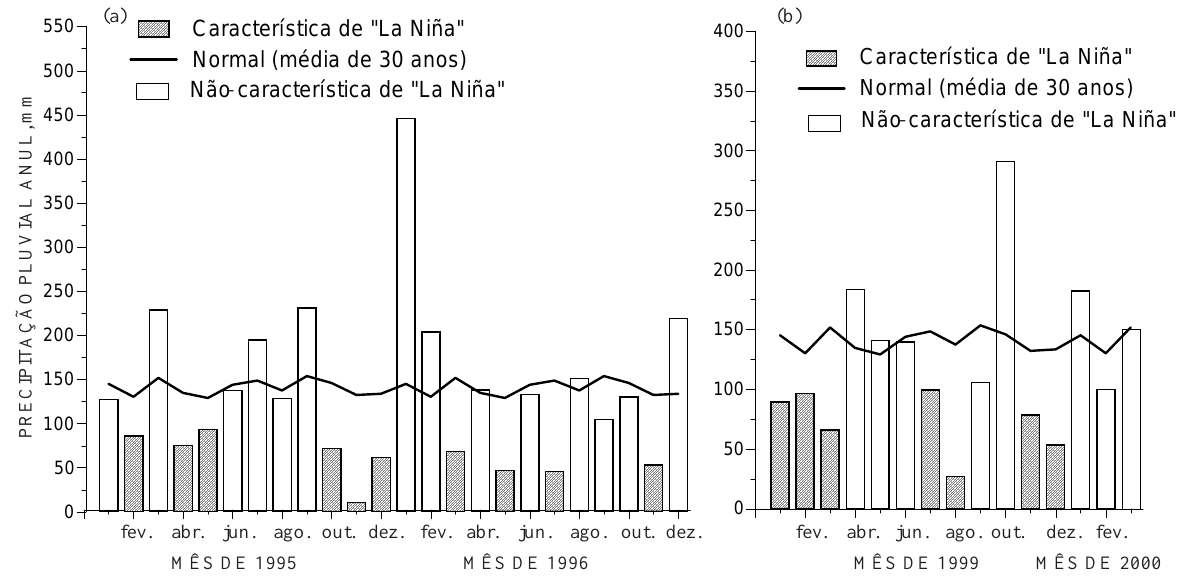
Figura 3. Distribuição da precipitação pluvial mensal durante o fenômeno “La Niña” de 1995/1996 (a) e 1999/2000 (b) e precipitação pluvial normal (média de 30